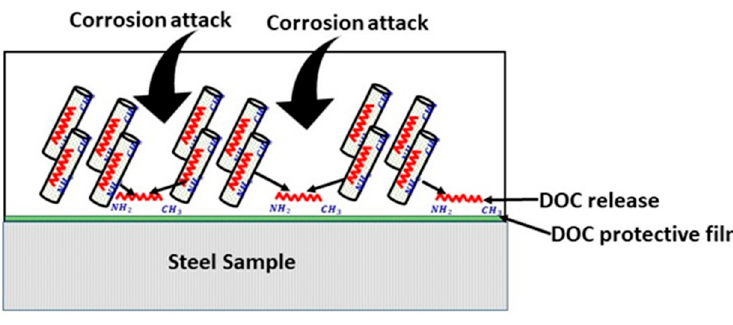
Figure 9. Schematic diagram of the healing mechanism in nanocomposite coatings. Figure 8. Bode graph of TNTs loaded with DOC ( a ), 5 wt.% at pH 2 ( b ), 5 wt.% at pH 5, phase angle measured of TNTs loaded with DOC ( c ), 5 wt.% at pH 2 ( d ), 5 wt.% at pH 5 ( e ); equivalent circuit used for fitting of EIS data.